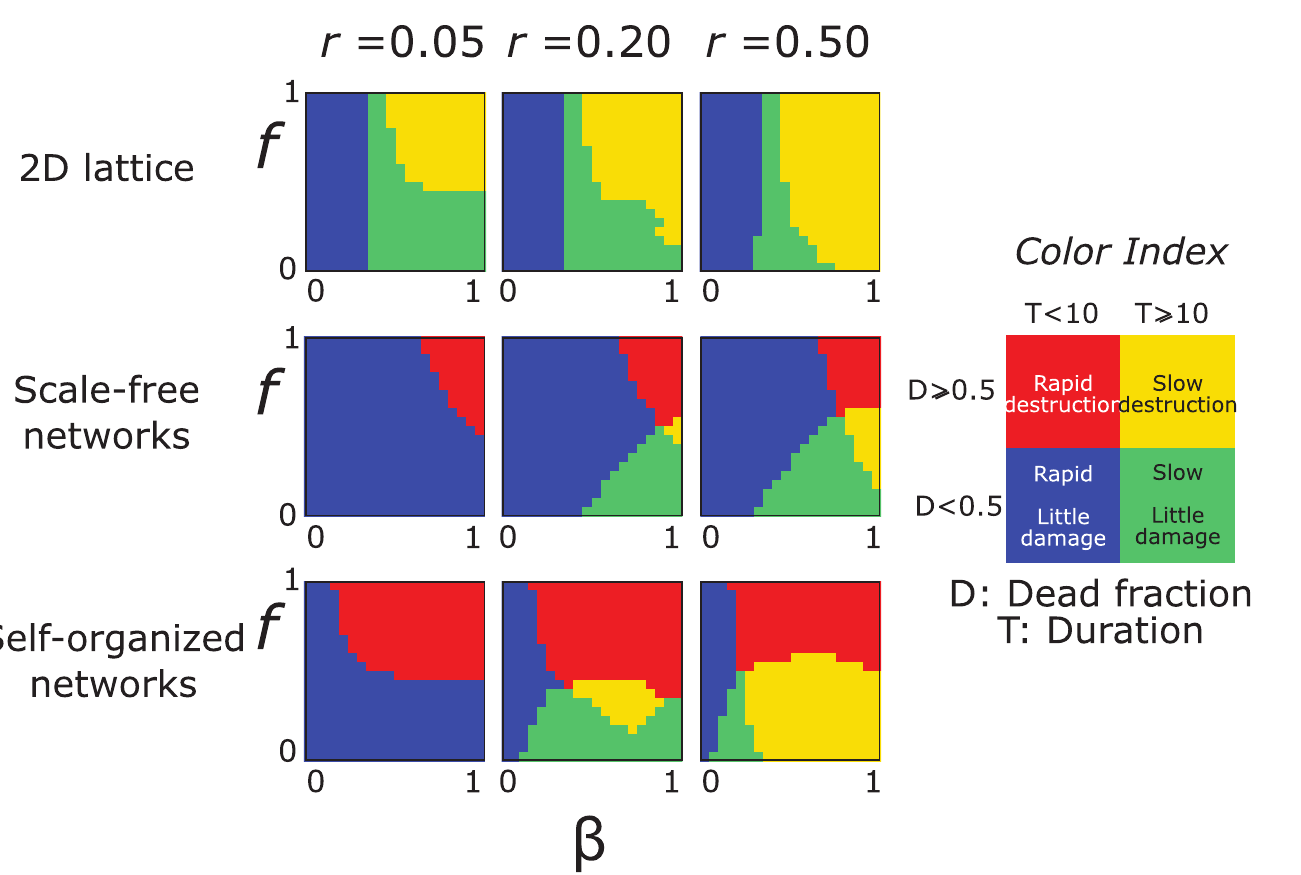
Fig 4. Combination of the results on dead population and duration. The color in the plots, as explained in the index, indicates whether the infection destroyed more or less than half the population and whether it lasted more or less than 10 steps. Red and yellow indicate the areas of larger